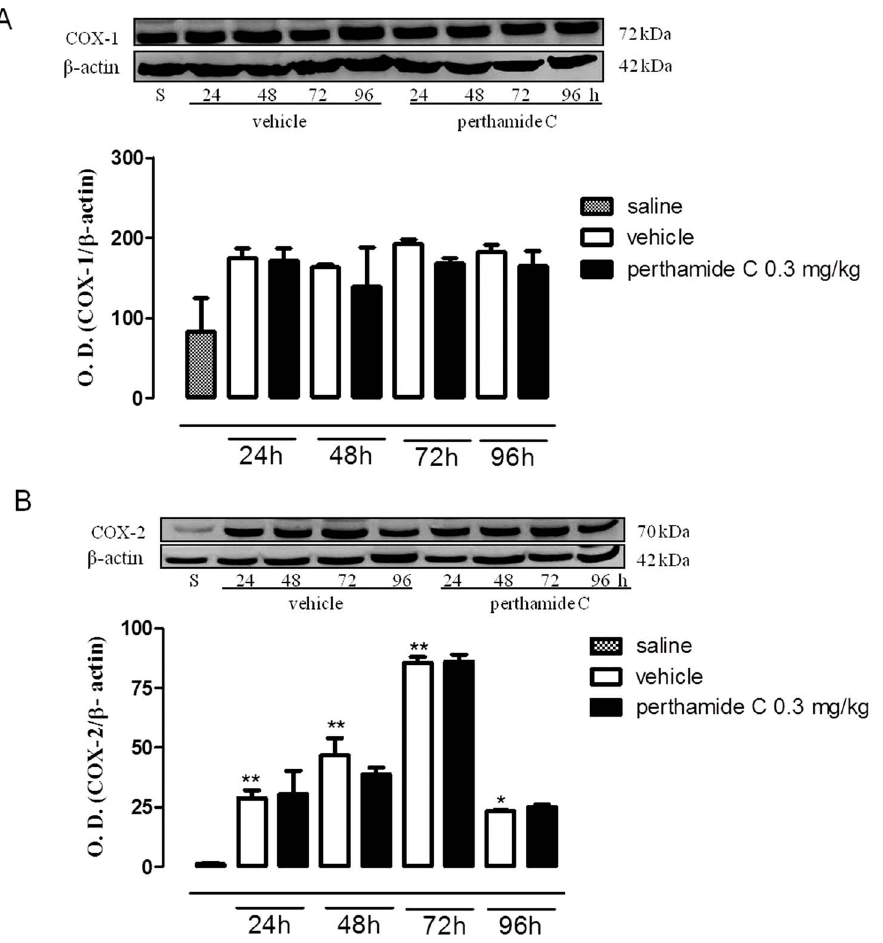
Figure 4. Western blot analysis of COX-1 and COX-2 in the late phase of the paw edema. Expression of COX-1 (A) and COX-2 (B) were evaluated in paws homogenates obtained from mice treated with perthamide C, vehicle or saline at 24, 48, 72, 96 h following l -carrageenan injection. (n=4 paws for each treatment and time point) * P , 0.05 ** P , 0.01 vs saline. Image is representative of three separate experiments.